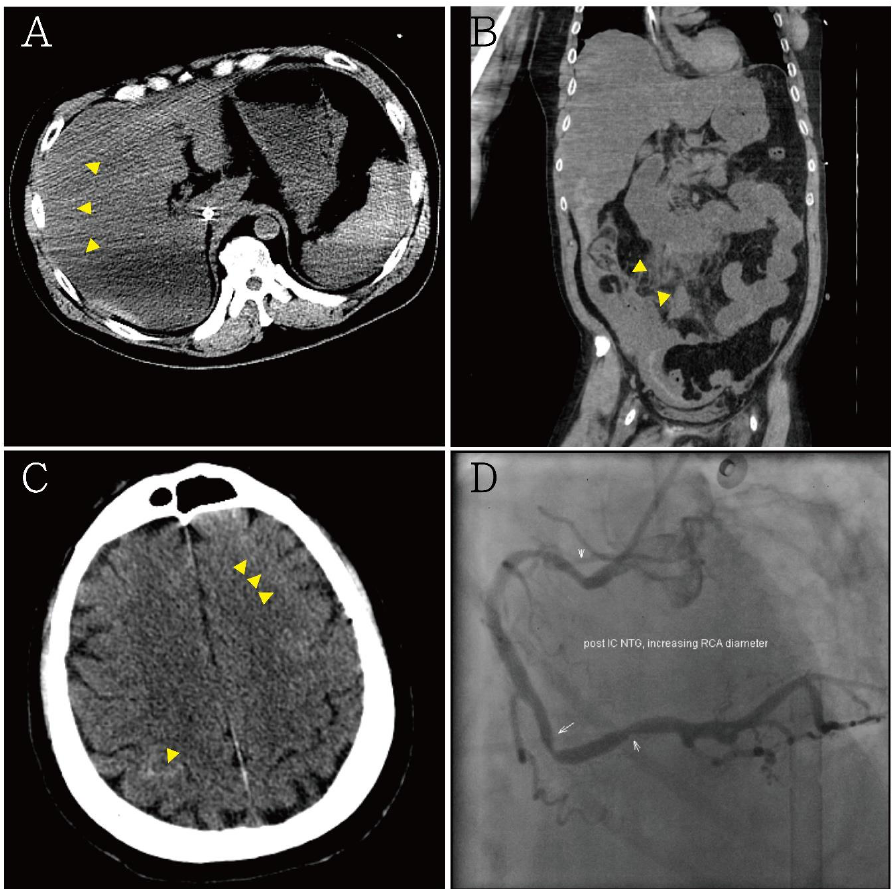
Figure 3. ( A , B ) Abdominal computed tomography showing hemoperitoneum due to internal bleeding (yellow arrowheads), liver laceration was suspected; ( C ) brain computed tomography showing minimal bilateral sulci subarachnoid hemorrhage (yellow arrowheads); ( D ) diagnostic coronary angiography showing only coronary artery spasm and native left and right coronary artery diameters with an increased myocardial bridge after intra-coronary nitroglycerin injection. There was no occluded segment or flow-limiting lesion.